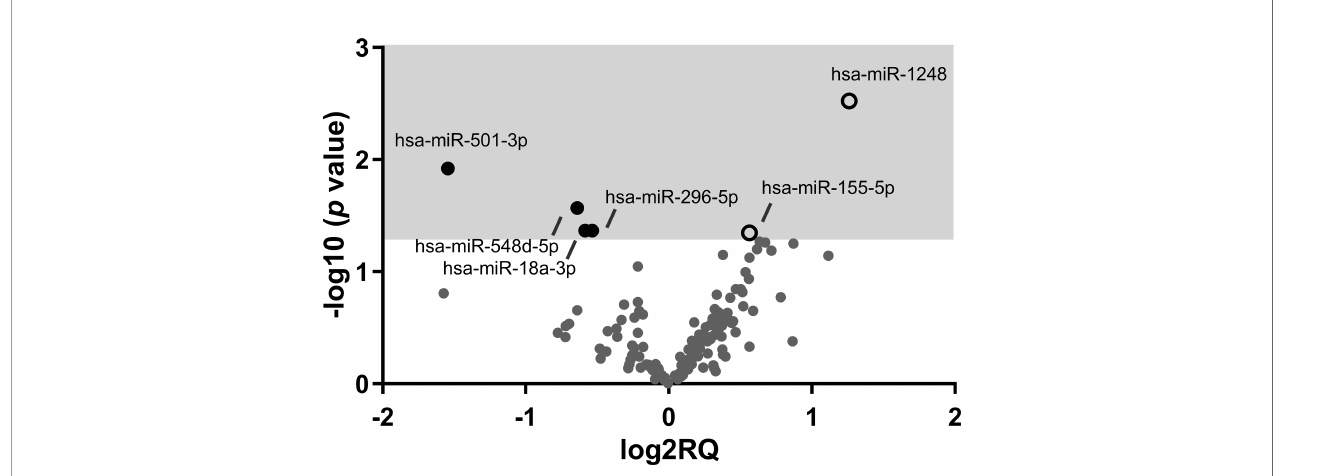
FIGURE 1 | Volcano plot showing the results of the miRNA pro fi le analysis comparing EARLY and LATE-treated groups of HIV-infected patients. Graph of log2 Relative Quantity ratio (log2RQ) against log10 p value signi fi cance (-log10 p value) from 142 quanti fi ed miRNAs. Open white spots represent upregulated genes and black spots represent downregulated genes on EARLY treated (n=7) compared to LATE (n=11) treated HIV-1-young adults.